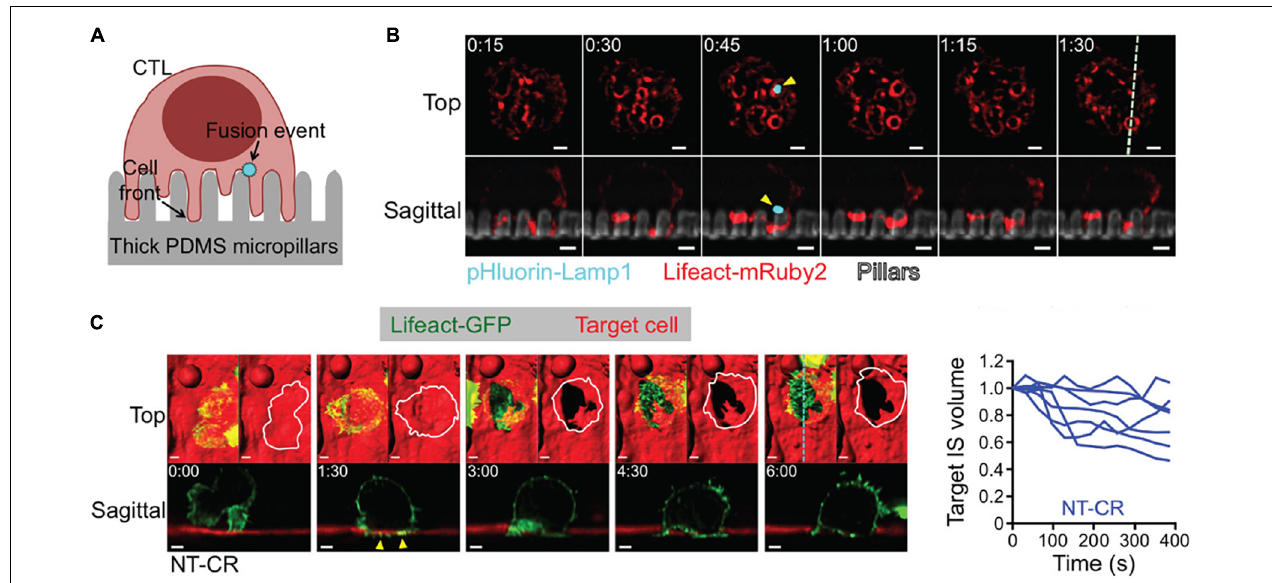
FIGURE 6 | 3D LSFM coupled with micropillar arrays improves temporal sampling during force measurements. (A) Schematic representation CTL engagement with micropillar arrays and the formation of synaptic protrusion and lytic granule fusion events. (B) LLSM of a CTL expressing Lifeact-mRuby2 (red) and pHluorin-Lamp1 (blue) engaged with a micropillar array (gray). The top row provides an x-y view from above. The bottom row shows an axial cross section of the region denoted by the dashed line in the upper right panel. Yellow arrows indicate the site of a fusion event. Time is given in minutes:seconds, scale bars: 2 µ m. (C) (Left) LLSM of a CTL expressing Lifeact-GFP (green) engaging with a target cell (red). The top row provides an x-y view from above with a surface rendering visualization. The bottom row shows an axial cross section of the region denoted by the cyan dashed line in the upper right panel. Yellow arrows indicate protrusions into the target cell. Time is given in minutes:seconds, scale bars: 2 µ m. (Right) Target cell volume plotted as a function of time. Each curve represents an individual CTL-target cell engagement. Images are reproduced with permission from Tamzalit et al.